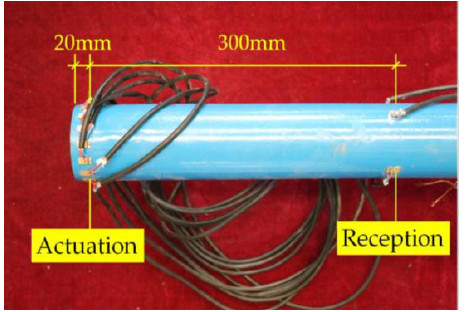
Figure 22. The layout of the PZT patch array on the surface of the tested pipe.